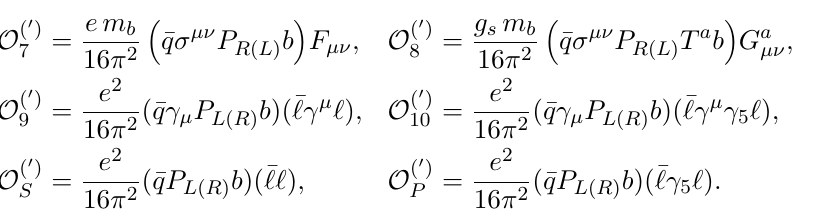
Figure 8. Contour plot of the allowed 2HDM-II parameter space in the (tan β − m the mass difference in the mixing of B d and B s mesons. The lighter contour indicates the allowed parameter space at 2 σ confidence level while the darker contour corresponds to 1 σ